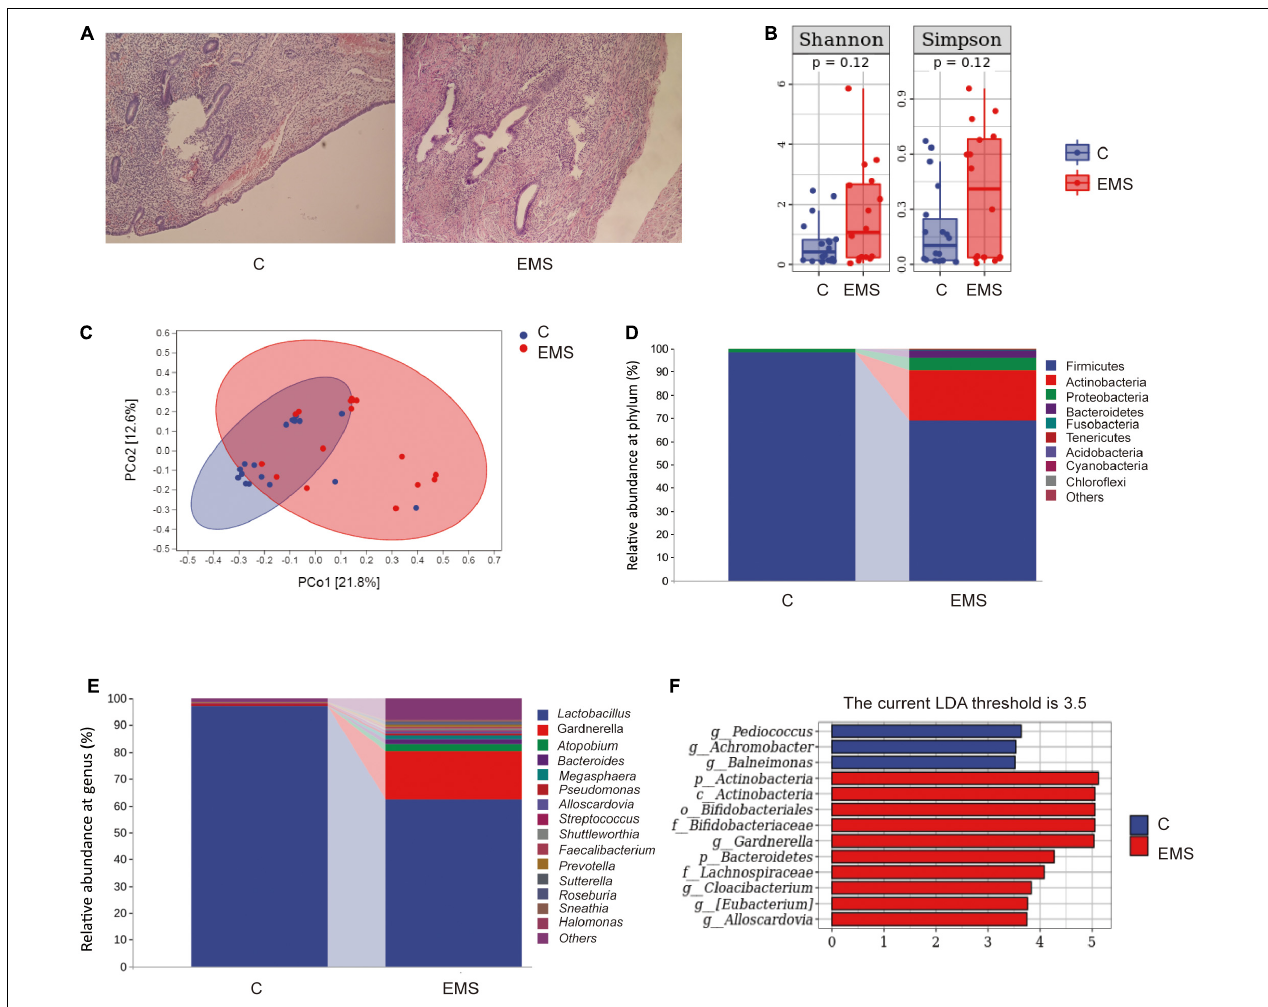
FIGURE 1 | Dysbiosis of vaginal microbiota patterns in patients with endometriosis and control women. (A) The typical endometrium pathological examination results of endometriosis and control women. (B) Comparison of alpha diversity indices (Chao1 index and Shannon diversity index) between two groups. (C) Principal coordinate analysis based on unweighted UniFrac distances revealed that the normal women bacterial communities clustered separately from patients with endometriosis bacterial communities, which were more similar to each other. Each circle represents a single sample, colored by group. The eigenvalues of axe principal coordinate (PC1 and PC2) were 21.8% and 12.6%, respectively. (D,E) Taxonomic composition analysis of phylum (D) and genus (E) between two groups. (F) LDA effect size identified the most differentially abundant taxa between the two groups. Only taxa meeting an LDA significant threshold of > 3.5 are